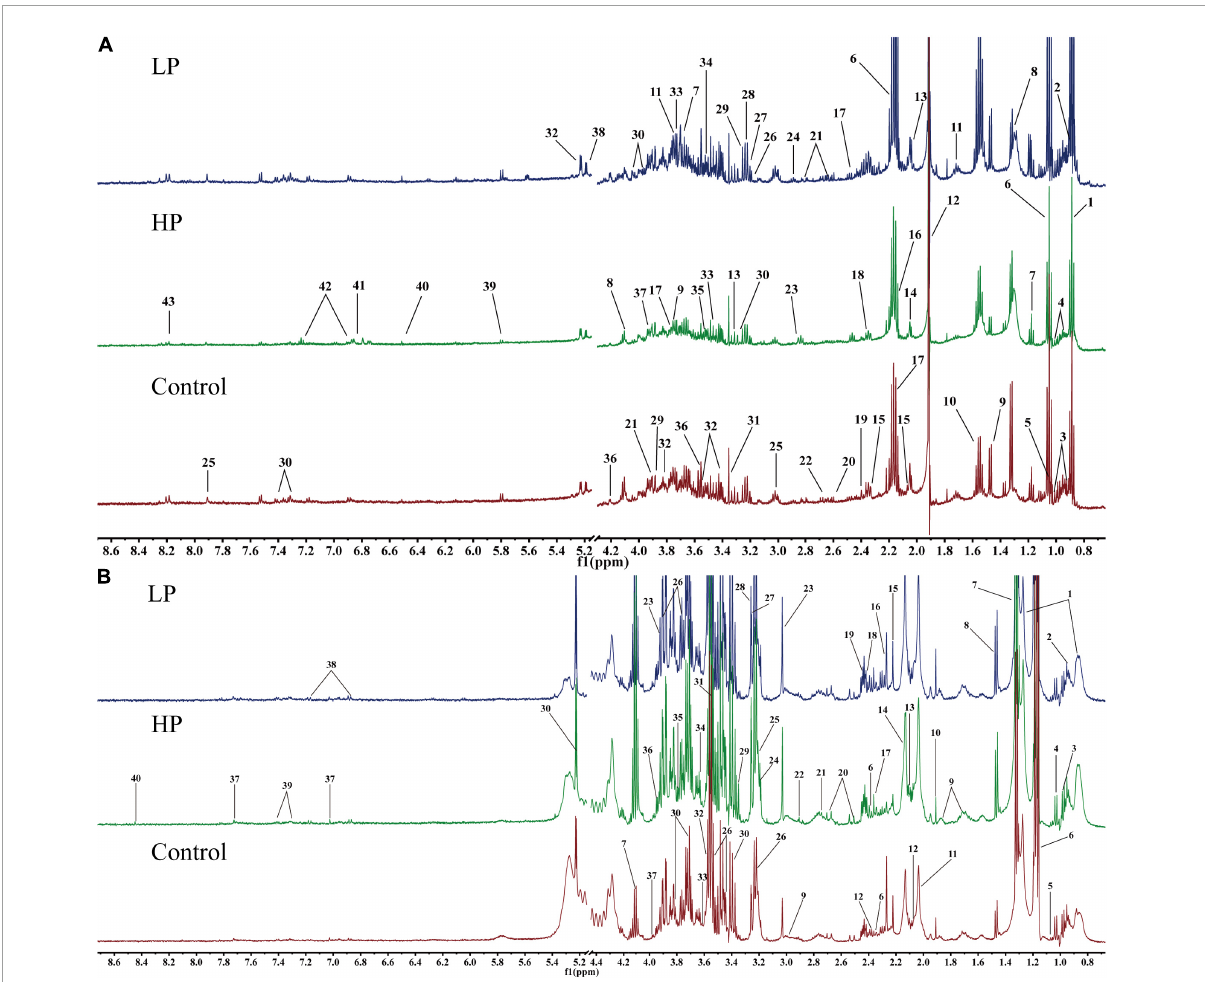
FIGURE3 Representative 1 H-NMR metabolic profiles of rat feces and serum. (A) Representative 1 H-NMR metabolic profiles of rat feces. 1, lipid; 2, butyrate; 3, isoleucine; 4, leucine; 5, valine; 6, propionate; 7, ethanol; 8, lactate; 9, alanine; 10, citrulline; 11, arginine; 12, acetate; 13, proline; 14, N-acetylglucosamine; 15, glutamate; 16, methionine; 17, glutamine; 18, pyruvate; 19, succinate; 20 PUFA; 21, aspartate; 22, dimethylamine; 23, trimethylamine; 24, asparagine; 25, histidine; 26, choline; 27, β -xylose; 28, taurine; 29, betaine; 30, phenylalanine; 31, methanol; 32, α -glucose; 33, β -glucose; 34, inositol; 35, glycine; 36, threonine; 37, glycolate; 38, α -xylose; 39, uracil; 40, fumarate; 41, 3-hydroxyphenyl propionic acid; 42, tyrosine; 43, hypoxanthine. (B) Representative 1 H-NMR metabolic profiles of rat serum. 1, lipid; 2, isoleucine; 3, leucine; 4, valine; 5, isobutyrate; 6, 3-hydroxybutyrate; 7, lactate; 8, alanine; 9, lysine; 10, acetate; 11, N-acetylglucosamine; 12, glutamate; 13, glutamine; 14, O-acetyl glycoprotein; 15, acetone; 16, acetoacetate; 17, pyruvate; 18, succinate 19, carnitine; 20, citrate; 21, dimethylamine; 22, trimethylamine; 23, creatine; 24, choline; 25, phosphorylcholine; 26, β -glucose; 27, trimethylamine oxide; 28, betaine; 29, scyllo-inositol; 30, α -glucose; 31, glycine; 32, threonine; 33, propanetriol; 34, inositol; 35, arginine; 36, 1-methylhistidine; 37, histidine; 38, tyrosine; 39, phenylalanine; 40,